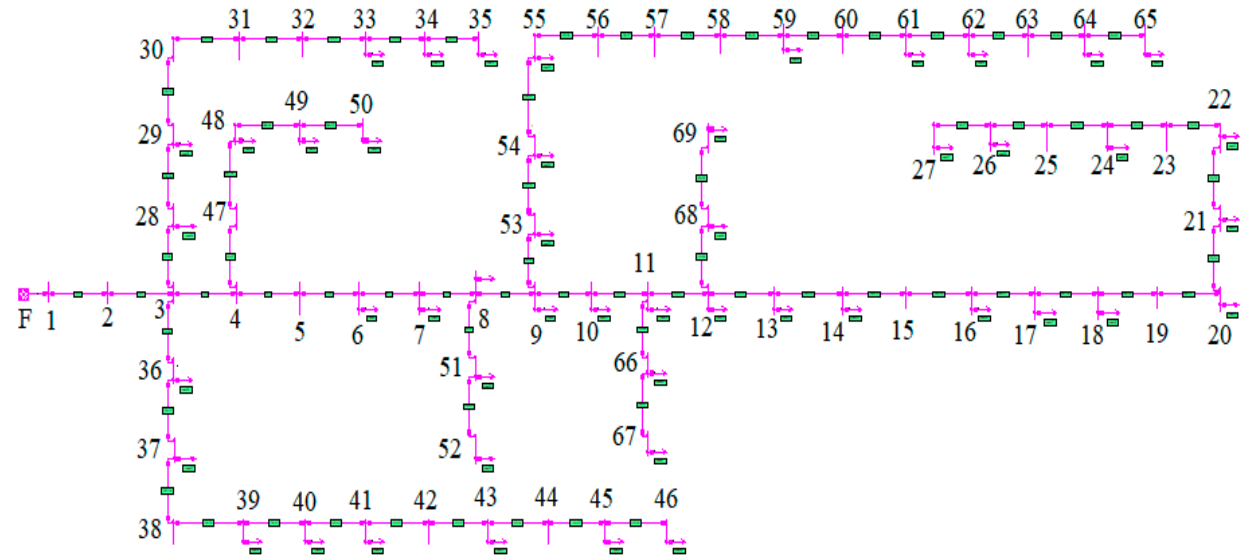
Figure 2. IEEE 69 RDS implementation by NEPLAN.